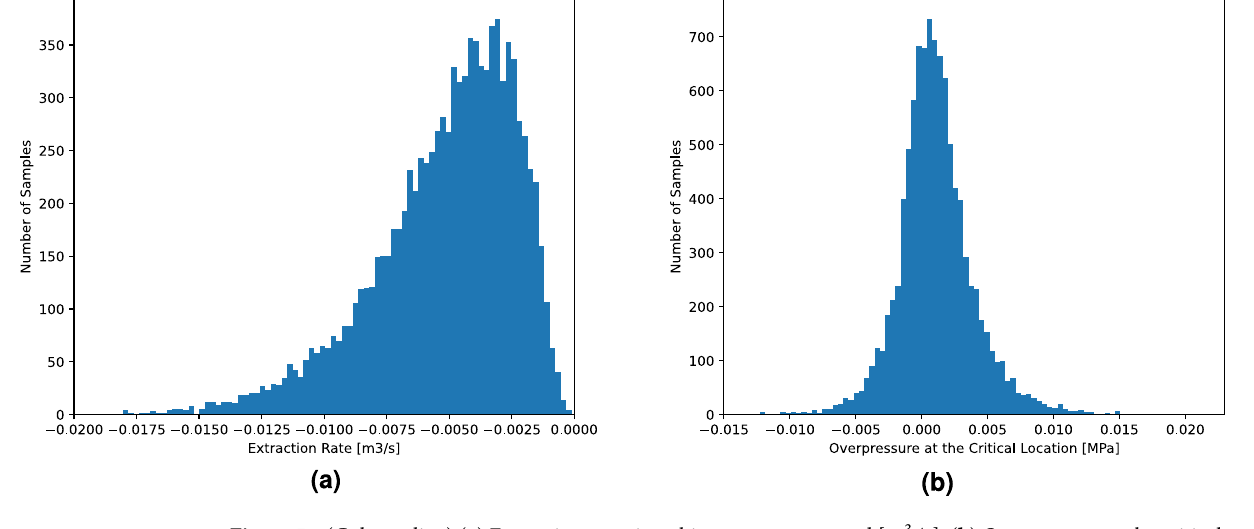
Figure 5. (Color online) ( a ) Extraction rates in cubic meters per second [ m 3 / s ]; ( b ) Overpressure at the critical location in pressure units [MPa]. These figures were created using Julia Version 1.6.2 73,74 , and the DPFEHM framework 62